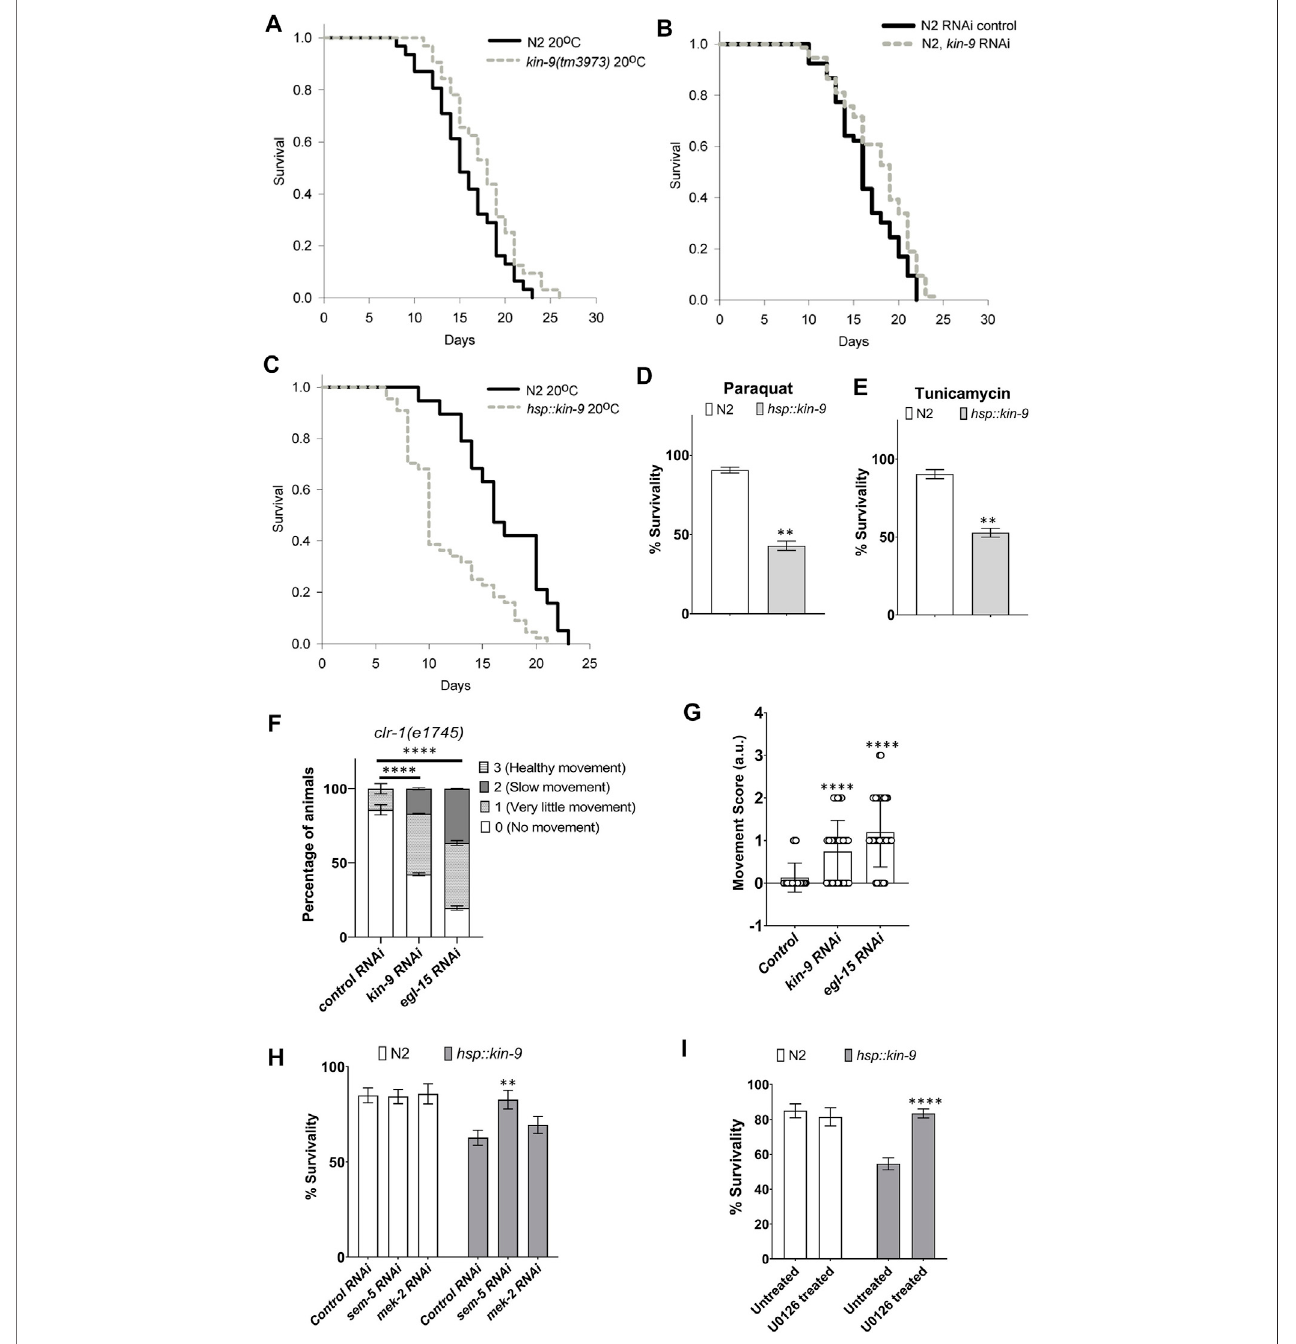
FIGURE 3 | Loss of kin-9 function extends lifespan. (A) Lifespan graphs of kin-9 (tm3973) mutants compared to N2 (B) Lifespan analysis of animals following control and kin-9 RNAi knockdown during adulthood. (C) Lifespan graphs of hsp::kin-9 animals compared to N2. (A – C) See the Methods section and Supplementary Table S3 for statistics performed. (D,E) Bar graph showing the survivability of hsp::kin-9 adults compared to N2 following paraquat (200 mM) and tunicamycin (25 ng/ μ L) exposure for 2hrs. (F,G) Staggered bar graphs (F) and bar graphs (G) showing the analyses of movement defect in clr-1 mutants following control, kin-9 and egl-15 RNAi.InpanelFmovementisquanti fi edonascaleof0 – 3andinpanelGaveragescoreformovementhasbeenplotted. (H) Bargraphsshowingthesurvivabilityof N2and hsp::kin-9 adultsin200 mMparaquatfor2hrsfollowingcontrol, sem-5 and mek-2 RNAiknockdown. (I) BargraphsshowingthesurvivabilityofN2and hsp::kin-9 adults in 200 mM paraquat for 2hrs following U0126 inhibitor treatment. (D – I) Data represent the mean of two to three replicates ( n > 50 animals in each replicate) and errorbarsrepresentthestandarddeviation.Statisticalanalysesweredoneusingmultipleunpaired t -testswithWelchcorrection (D,E,H,I) ,one-wayANOVAwithmultiple comparison test (G) and 2-wayANOVA withSidak multiple comparison test (F) .Signi fi cant differences areindicated bystars (*): ** ( p < 0.01),*** ( p < 0.001) and **** ( p < 0.001).